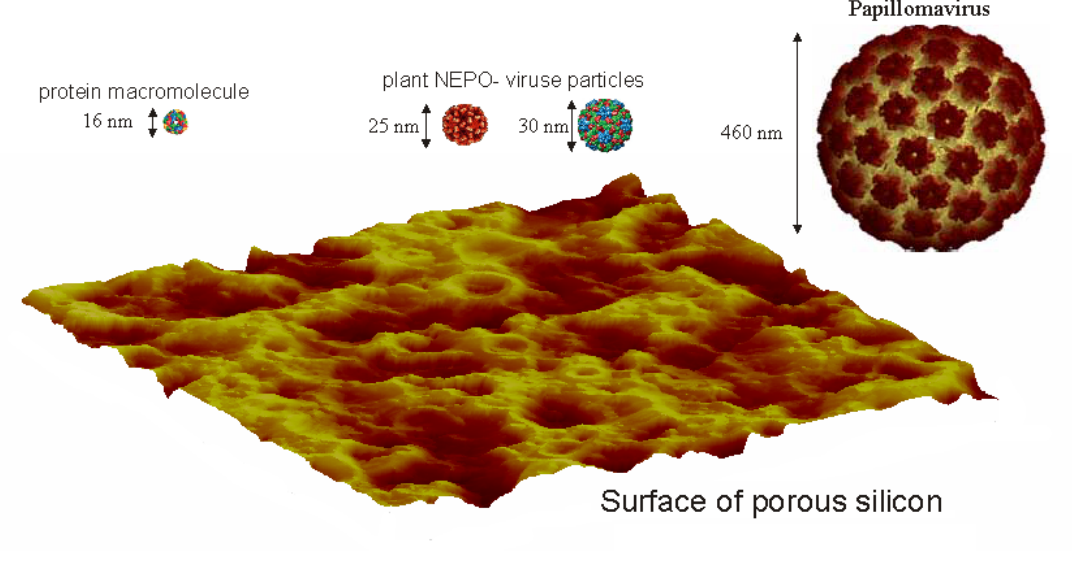
Figure 2. Atomic force microscopic image of mesoporous silicon surface and images of protein macromolecule, NEPO plant virus and papilloma virus particles. The numbers represent their characteristic sizes.